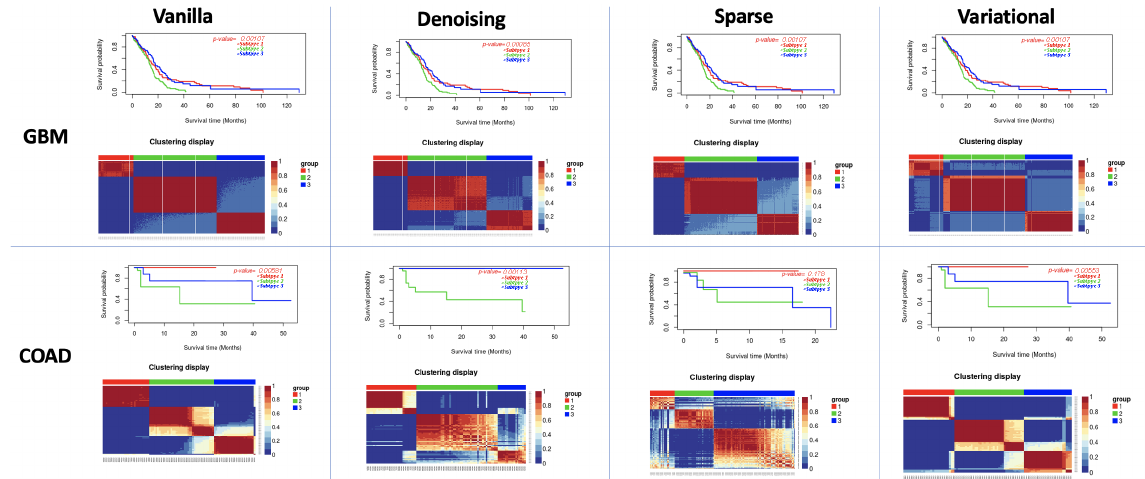
Figure 3. K-means survival analysis on Datasets. In each subfigure, ( Top ): Kaplan-Meier survival curves of three identified clusters. The log-rank test confirmed a difference in survival profiles among clusters; ( Down ): Patient to patient similarity and identified clusters on the dataset.